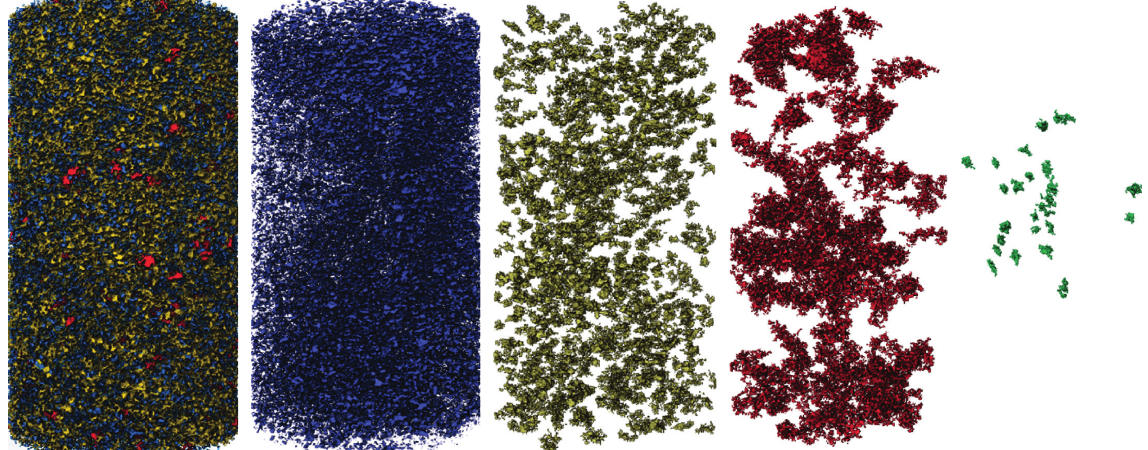
Figure 7: Spatial distribution of the pore structure of sample